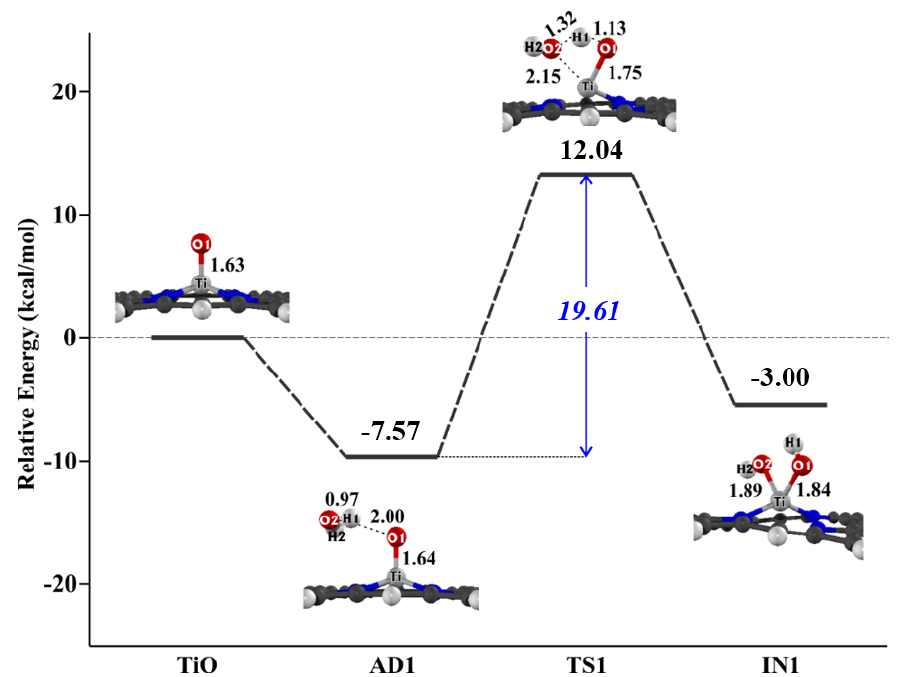
Figure 2. Water dissociation over the TiO-por active site. Light grey, red, blue, dark grey, and white balls represent Ti, O, N, C, and H atoms, respectively. Bond lengths are in Å .